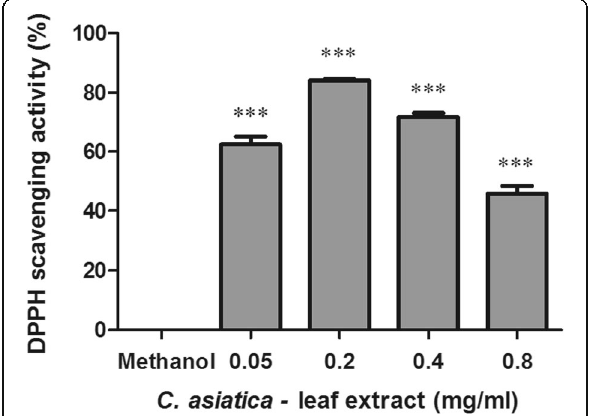
Fig. 1 Percentage DPPH scavenging activity of C LE (Values expressed as mean ± SD, *** p < 0.0001 compared to